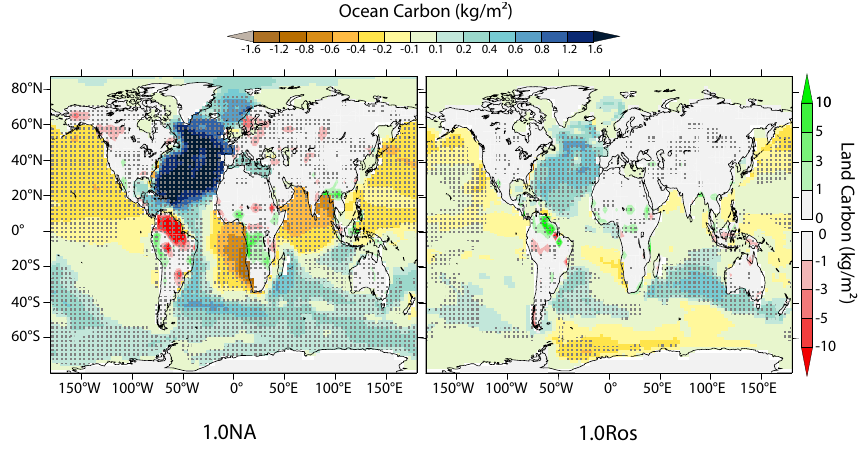
Fig. 5. Changes in the carbon stocks (kgm − 2 ) in the ocean and on land (note the different colour bars) for 1.0NA and 1.0Ros experiments, by the end of the perturbation (decadal average of model years 97–106). Stippled areas indicate where the ensemble mean anomaly is significantly different from zero at the 67% level (Student’s